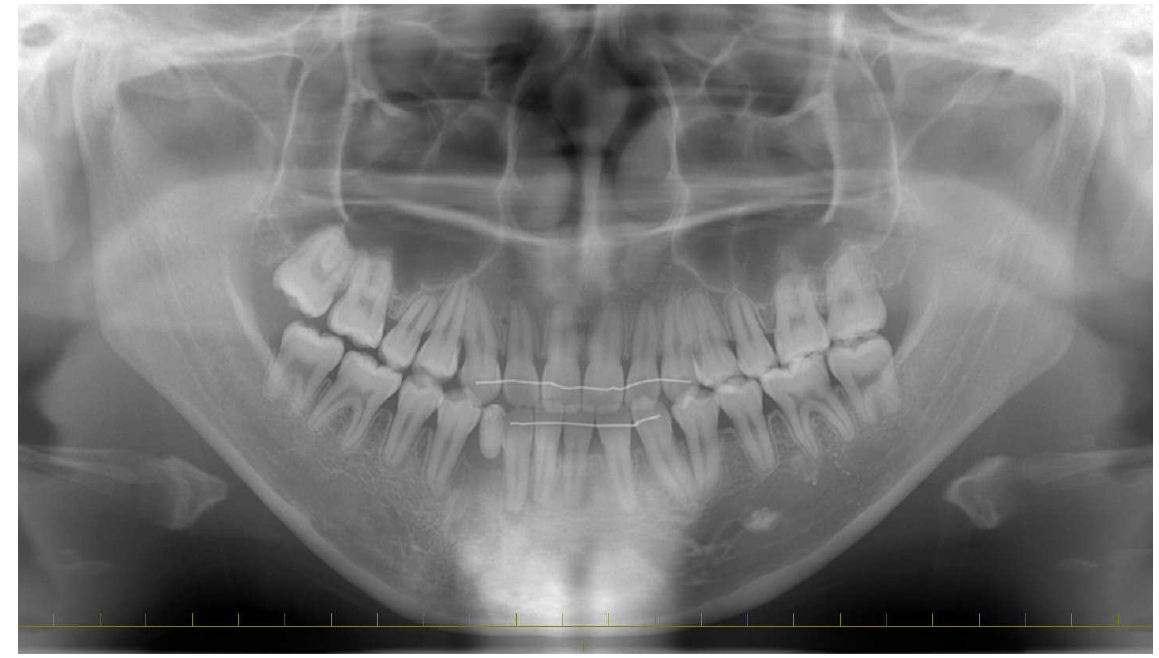
Figure 10. Post-treatment panoramic radiograph.